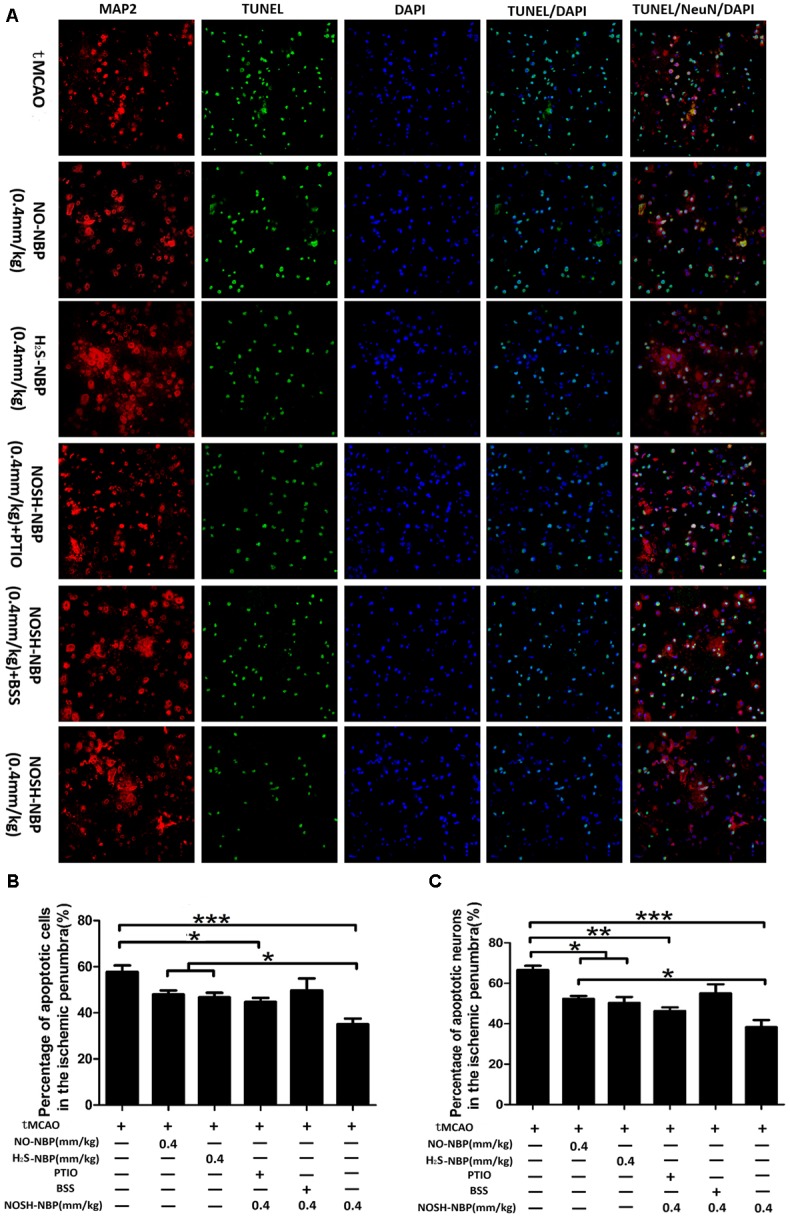
Effect of NO-NBP, H2S-NBP, and NOSH-NBP on neuronal apoptosis in the penumbral area of tMCAO mice. The model- group and test compounds- groups underwent tMCAO; the sham group underwent the same surgical procedure without the filament insertion. After MCAO being performed, mice in test compounds group were administrated with NO-NBP (0.4 mm/kg), H2S-NBP (0.4 mm/kg), NOSH-NBP (0.4 mm/kg) + PTIO, NOSH-NBP (0.4 mm/kg) + BSS or NOSH-NBP (0.4, 0.2, and 0.1 mm/kg) for 3 days. (A) Representative photographs of TUNEL. These images were analyzed by Image Pro Plus, and each datum was presented as (B) TUNEL positive cells and (C) neurons in per mm2 within five random independent view fields. The data were presented as mean ± SD (n = 3) and were analyzed by one-way ANOVA followed by post hoc Tukey test: ∗∗∗P < 0.001, ∗∗P < 0.01, ∗P < 0.05.